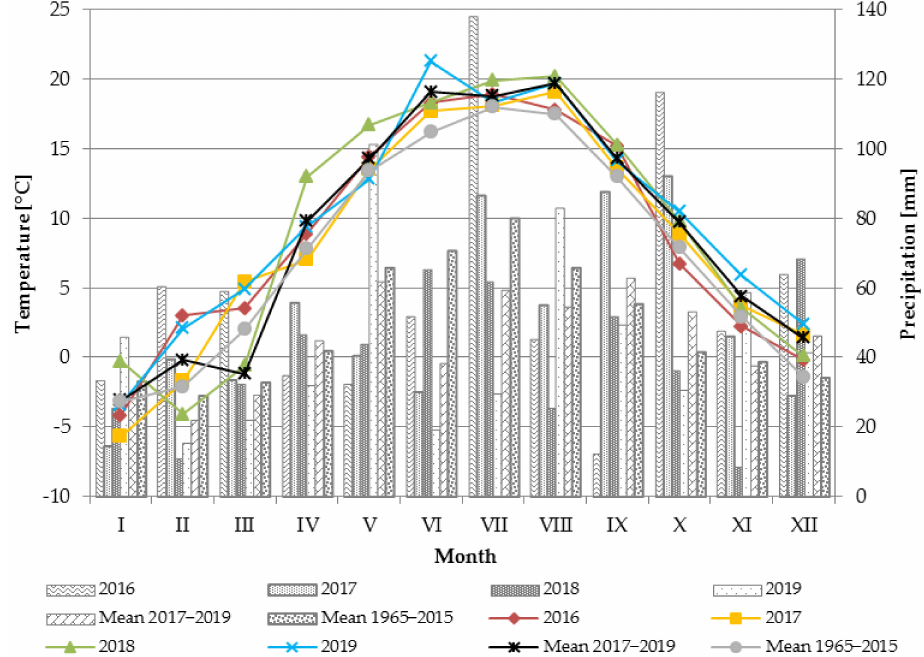
Figure 1. Air temperature and precipitation in the 2016–2019 growing seasons compared with the mean values (1965–2015); data provided by the Lublin-Radawiec meteorological station (Institute of Meteorology and Water Management—National Research